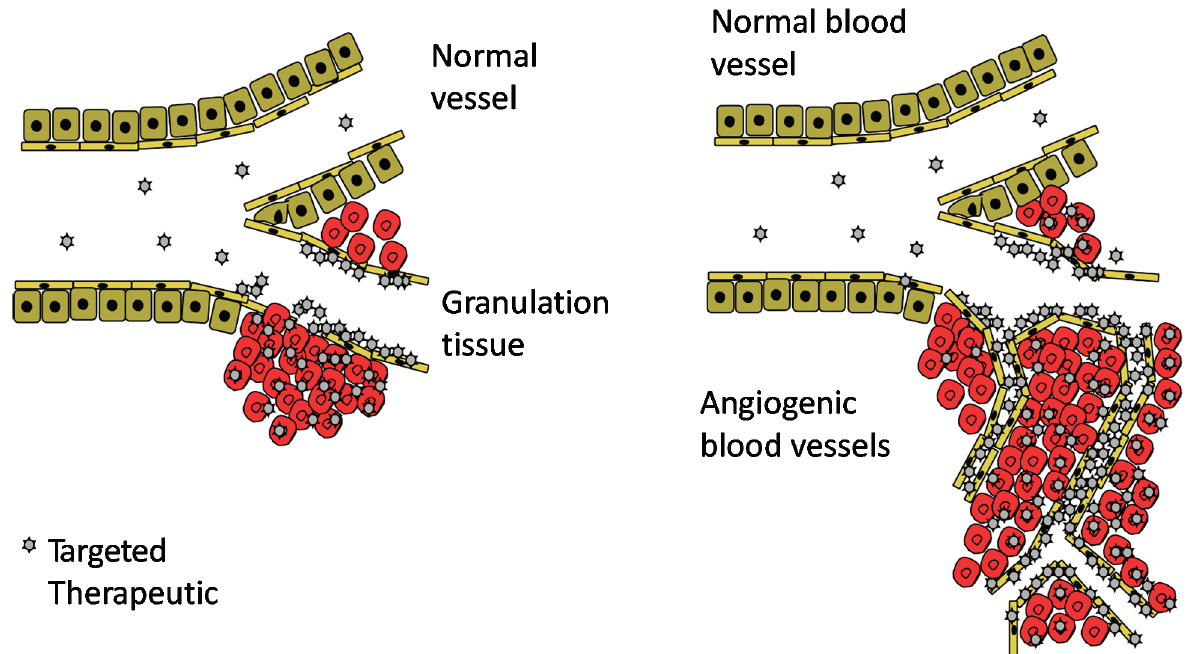
Figure 1. Target-specific drug therapies in tissue regeneration. Molecular fingerprints (“Zip/postal codes”) in the angiogenic vasculature of the regenerating tissues allow target organ-specific delivery of the systemically administered therapeutic molecules by affinity-based physical targeting (using peptides or antibodies as an “address tag”) to injured tissues undergoing repair. The desired outcome of the targeted therapies is similar to topical application: increased local accumulation and lower systemic concentration of the therapeutic